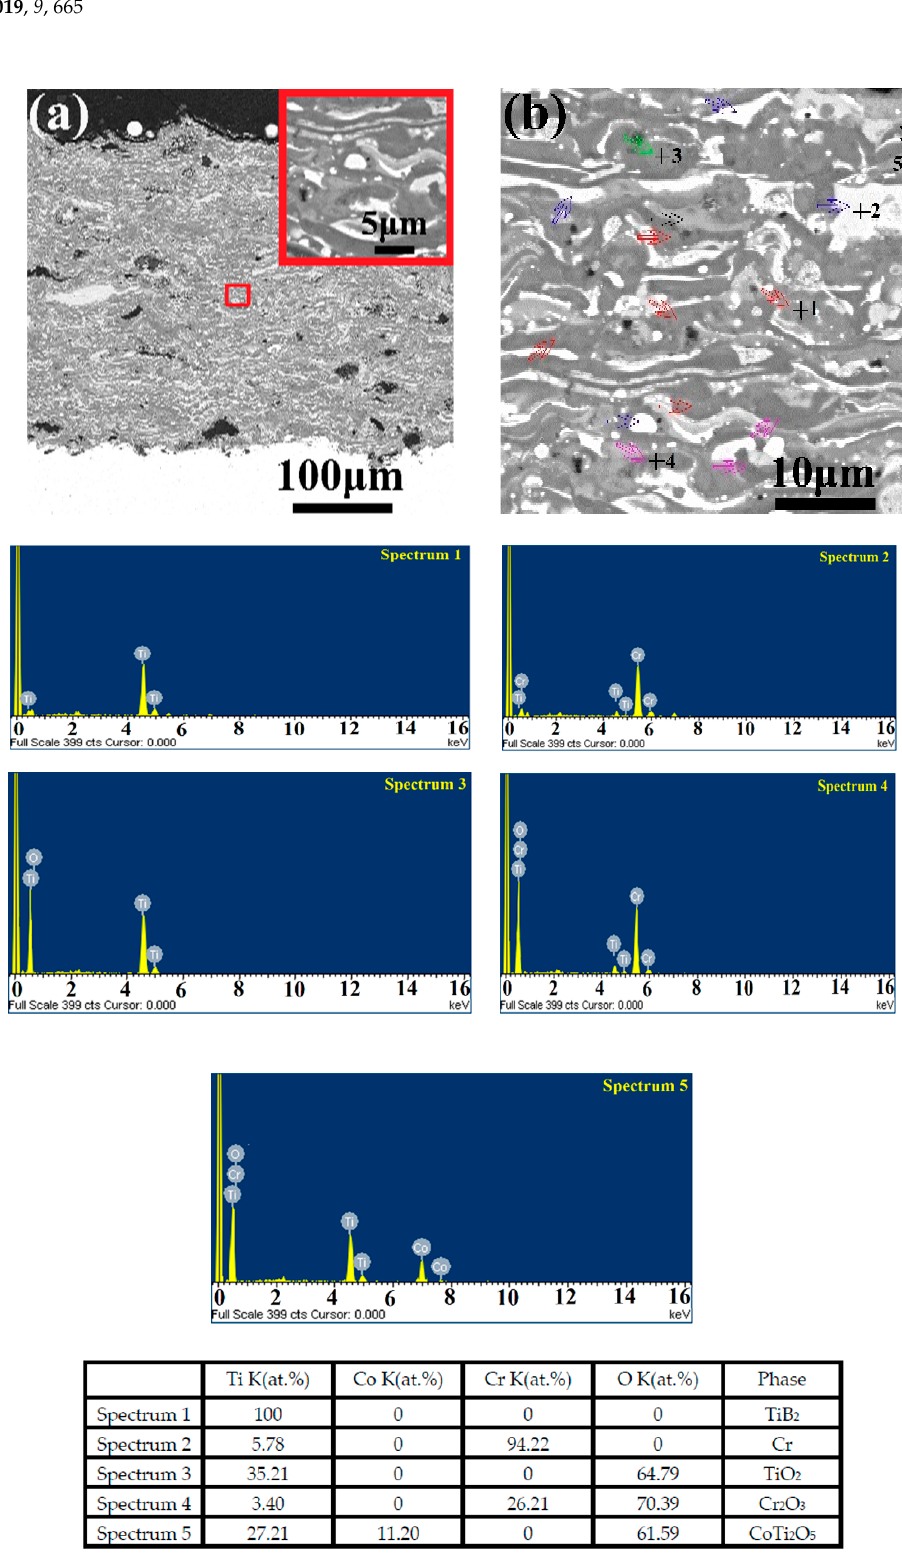
Figure 13. Cross-sectional morphologies and compositions of the TiB/CoCr coating: ( a ) 500×, and ( b ) 10000×.